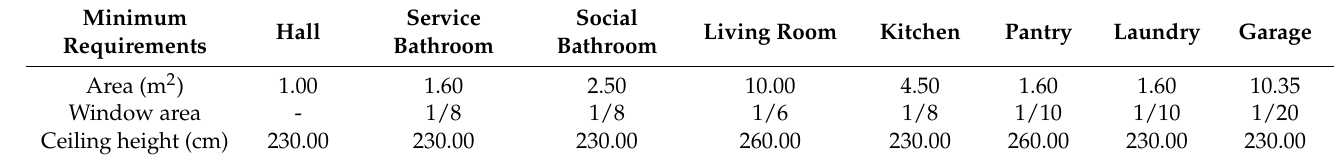
Table 2. Building code minimum requirements in Vila Velha and Florian ó